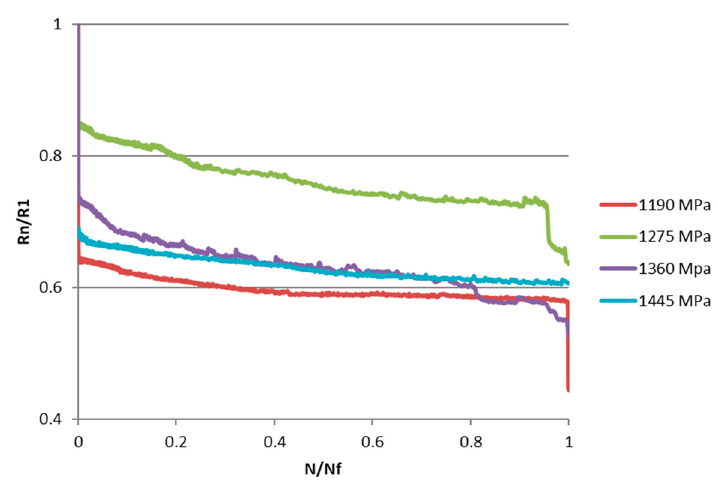
Figure 4. Trend of normalized stiffness for the various load levels applied.